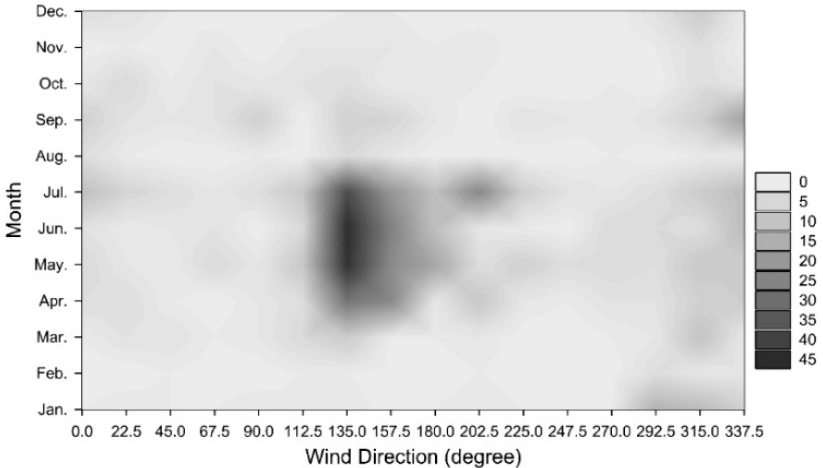
Figure 8. Number of wind directions for each month in SCs (see Table S4 for more detail). In SCs, PM2.5 and PM10 were 26.54 µg/m 3 (25.78–27.31 µg/m 3 , 95% CI) and 45.84 µg/m 3 (44.26–47.43 µg/m 3 , 95% CI), respectively, which were higher than the annual means (Figure 9 and Table S5). In particular, in SC, the concentrations of the metal components were higher than the total mean concentrations.